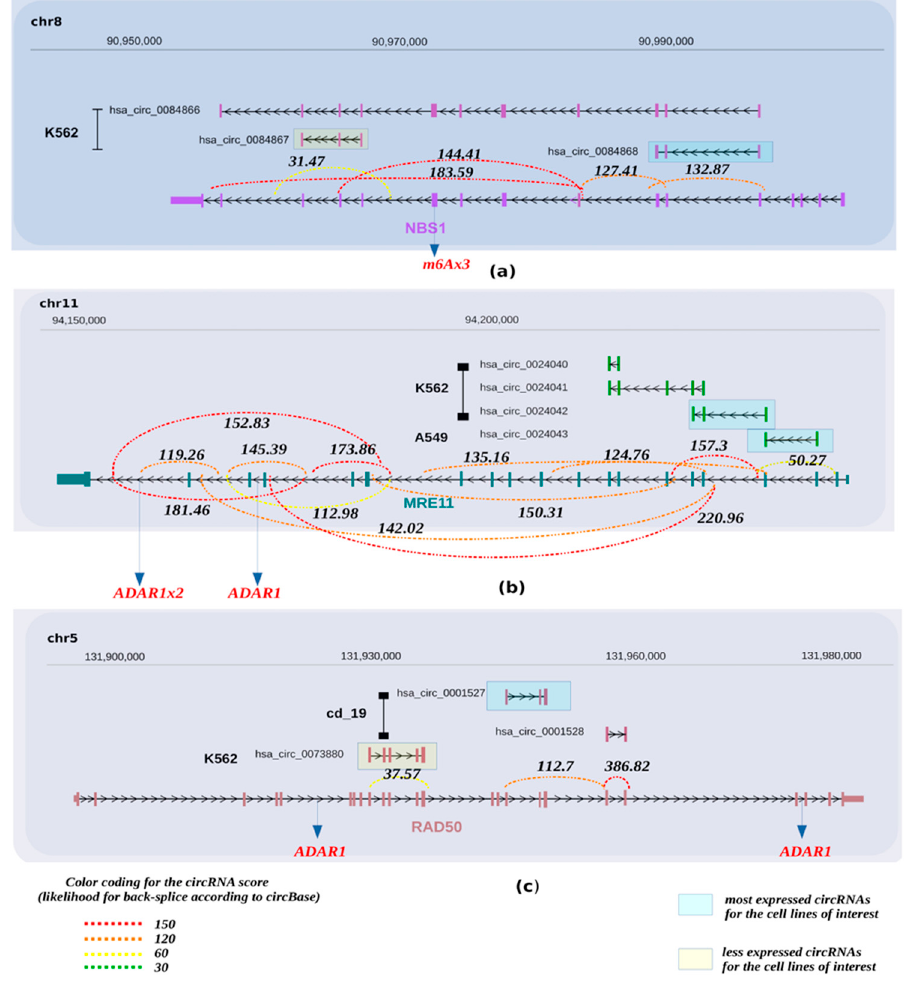
Figure 2. Potential circRNAs derived from the NBS1 , MRE11 , RAD50 gene loci. Predicted circRNAs at the NBS1 ( a ), MRE11 ( b ), RAD50 ( c ) gene loci, based on next generation sequencing (NGS) data, as deposited at circBase and CIRCpedia, are shown over the corresponding loci, based on human genome GRCh37/hg19. Cell lines in which NGS was performed to obtain the depicted circRNAs are also shown and were retrieved from circBase. The expression values for the estimated circRNAs were derived from the junction reads form of circBase and CIRCpedia from Ribo zero RNA-seq. The strength of the back-splicing event is demonstrated using a dashed line, where differentscores are shown for the expressed back-spliced events. Furthermore, we indicate from miCLiP experiments [91] a consensus of m6A sites and editing sites as derived from RNA editing events using the Jacussa pipeline [92] as well as from ADAR1 CliP binding sites.